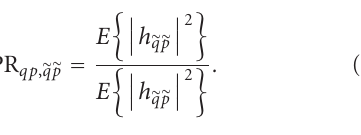
The random variable φ ( m ) represents the uniformly- ab distributed random phase o ff set associated with the path to each scatterer S ( m ) between the V or H component of the t Tx antenna elements and the V or H component of the Rx is the antenna elements. Similarly, the random variable φ ( n ) ab uniformly-distributed phase o ff set associated with the path to each scatterer S ( n ) r between the V or H component of the Tx antenna elements and the V or H component of the Rx antenna